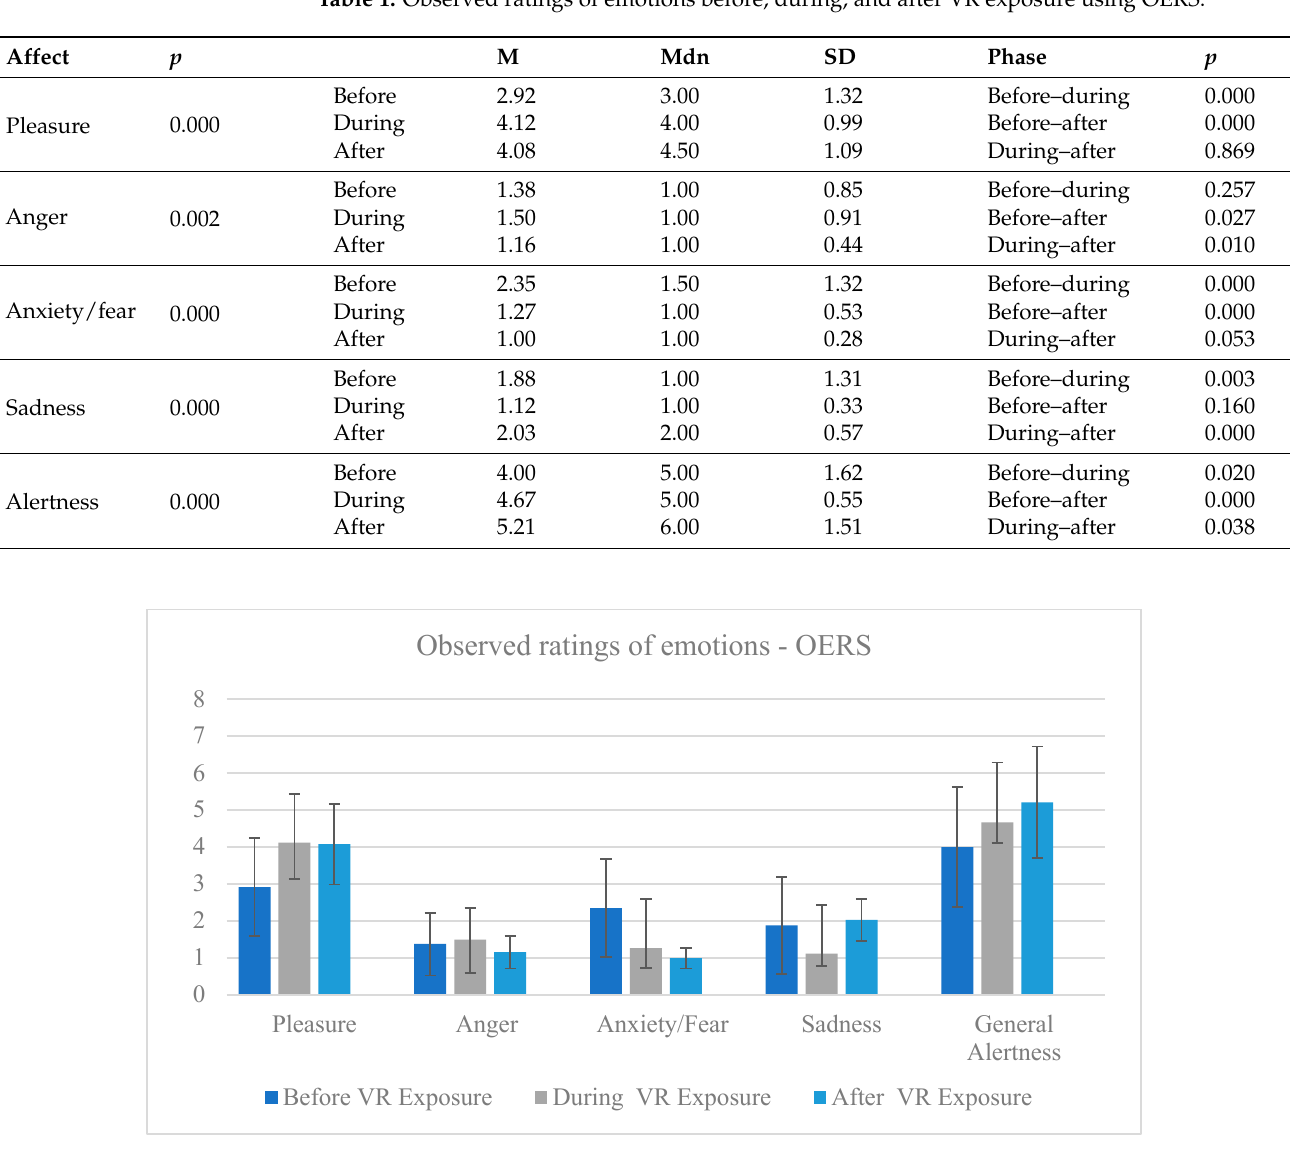
Figure 4. Observed ratings of emotions before, during, and after VR exposure using the OERS .